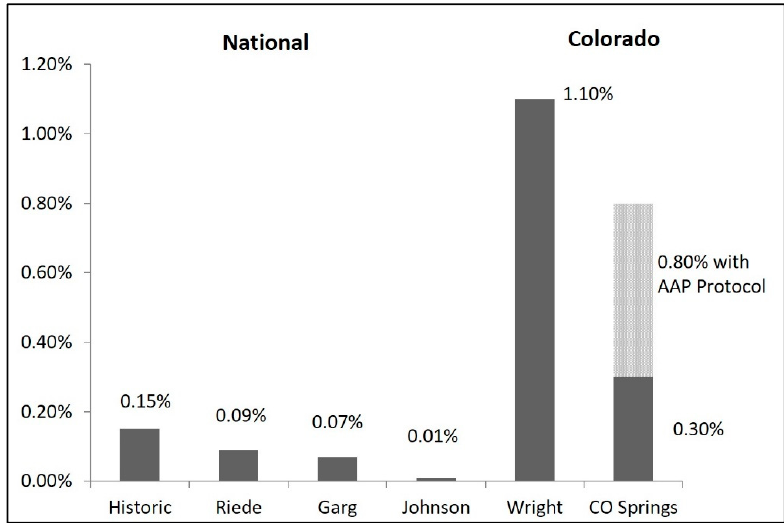
Figure 4. Colorado screening failure rates as compared to nationwide reports. Compared to national failure rates, failure rates at moderate altitude remain elevated; however, our modified protocol significantly improves on the failure rate found at similar altitude. The hatched bar indicates the theoretical AAP protocol failure rate in our newborn cohort.